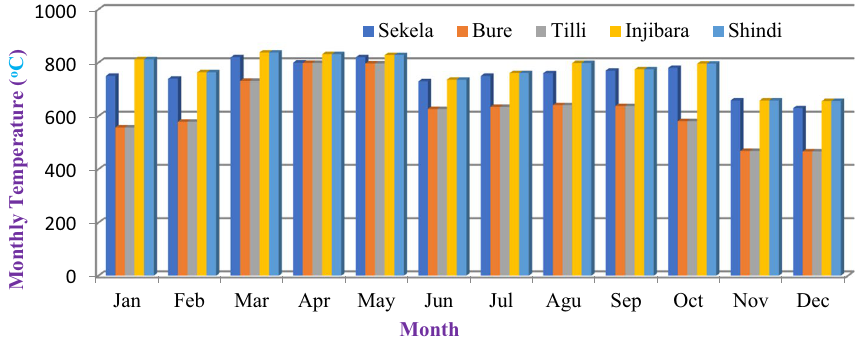
Fig. 2 Monthly temperatures of five stations around Fetam